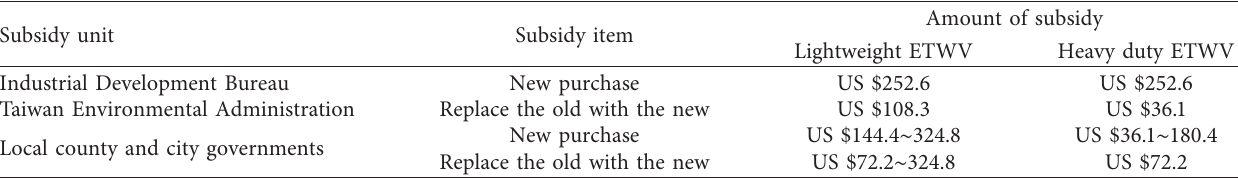
Table 1: Amount of subsidy for purchasing ETWVs in